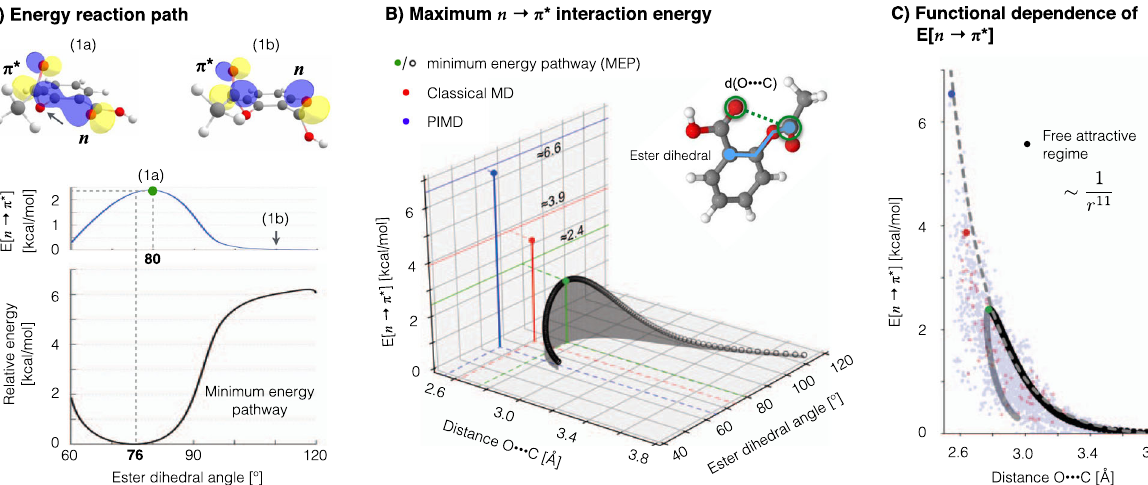
Fig. 1 Enhancement of the n → π * interaction by nuclear delocalization in Aspirin. A -Bottom Aspirin ’ s potential energy surface and A -Middle n → π * interaction energy E n ! π (cid:2) along the minimum energy pathway (MEP) of the ester ’ s dihedral angle. The energy E n ! π (cid:2) was computed using natural bond orbital (NBO) method 30,45 at CCSD/cc-pVDZ level of theory, whereby a positive energy value means stabilization and zero energy means absence of overlap between n and π * orbitals. Hence, a positive value implies a stabilization of the molecule. Both plots are in the same energy scale. A -Top The con fi guration (1a) (marked by the green circle) de fi nes the maximum interaction (stabilization) energy E n ! π (cid:2) along the MEP, while (1b) represents a con fi guration where overlap between lone-pair electrons ϕ ( n ) and the antibonding ϕ ð π (cid:2) Þ orbitals, and therefore the energy E n ! π (cid:2) , has gone to zero. B Estimations of the maximum E ≈ 6.6 kcal mol − 1 ) and classical MD (red circle, ≈ 3.9 kcal mol − 1 ) at 300K using n ! π (cid:2) interaction energy values reached while running PIMD (blue circle, the sGDML@CCSD model. As a reference, the energy E n ! π (cid:2) curve is plotted along the MEP trajectory as a function of its two main degrees of freedom, the interatomic distance d O ⋯ C and the ester ’ s dihedral angle. The maximum energy E n ! π (cid:2) value along the MEP is ≈ 2.4 kcal mol − 1 (green circle). C Approximate functional dependence of the interaction energy E n ! π (cid:2) on the oxygen (in hydroxyl) and carbon (in ester) interatomic distance d O ⋯ C . The 1/ r n function was fi